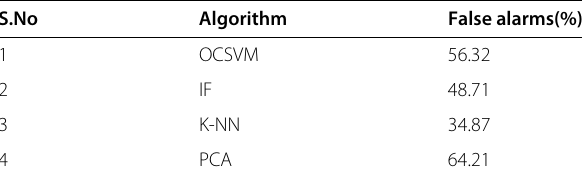
Table 1 Performance analysis of anomaly detectors (Gauthama Raman et al.